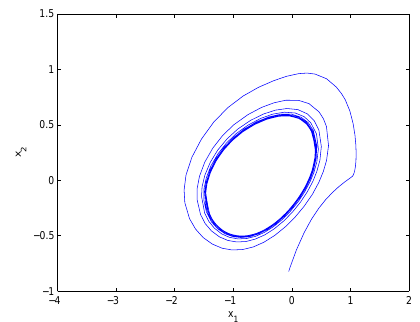
Fig.3. The trajectories of state of system (24) with activation function g ( x ( t )) = 1 ( x + tanh ( x )) and arbitrary initial condition. 5